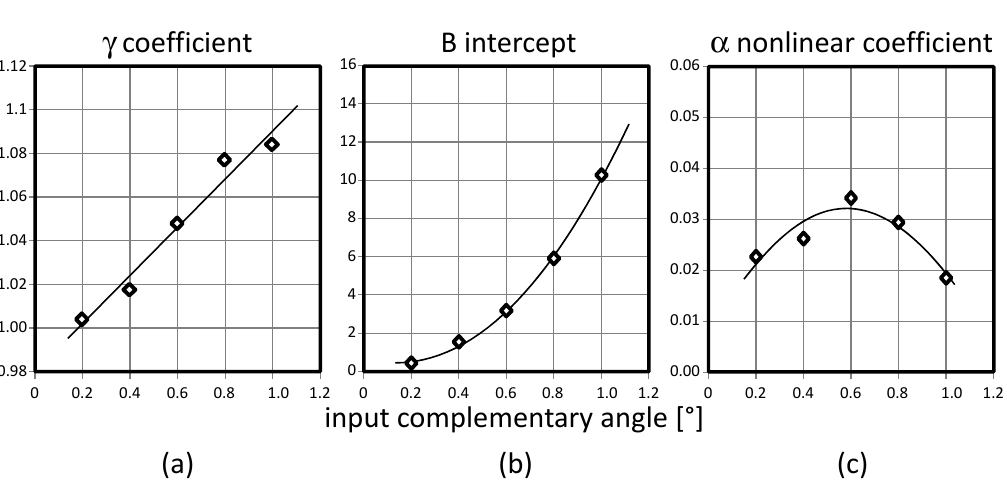
Figure 4. This figure reports the obtained values of the applied voltages that generated an EO interface for which a critical angle of the soliton is experimentally examined. The curves correspond to different input angles, whose values are reported on the right-hand side. All straight-line regression fits have a coefficient of determination R 2 = 1.